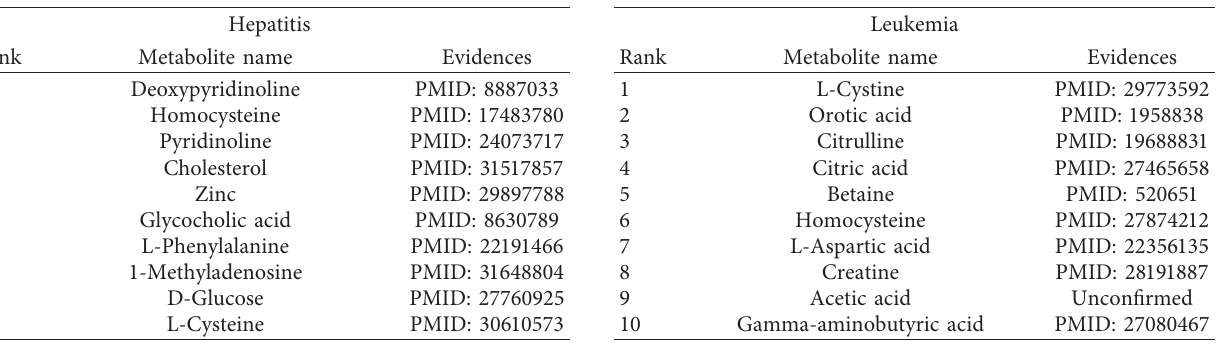
Table 3: Candidate metabolites of hepatitis. Table 4: Candidate metabolites of leukemia.